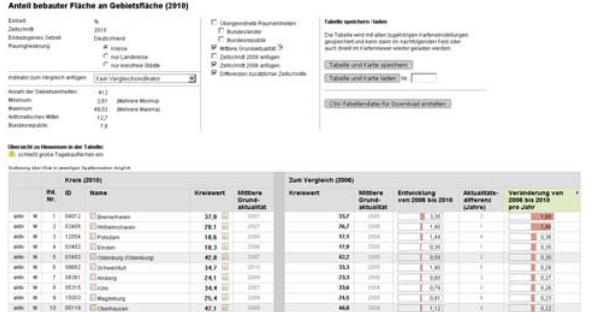
Figure 3. Tables showing the indicator values as well as